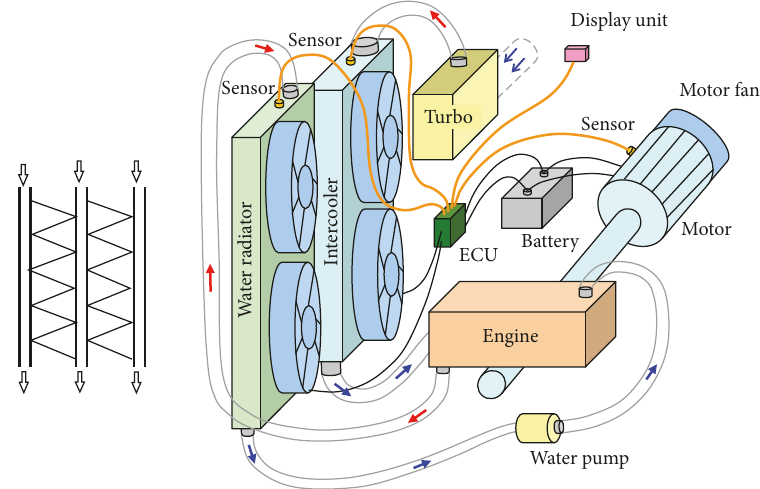
Figure 1: The radiator structure and the cooling control system